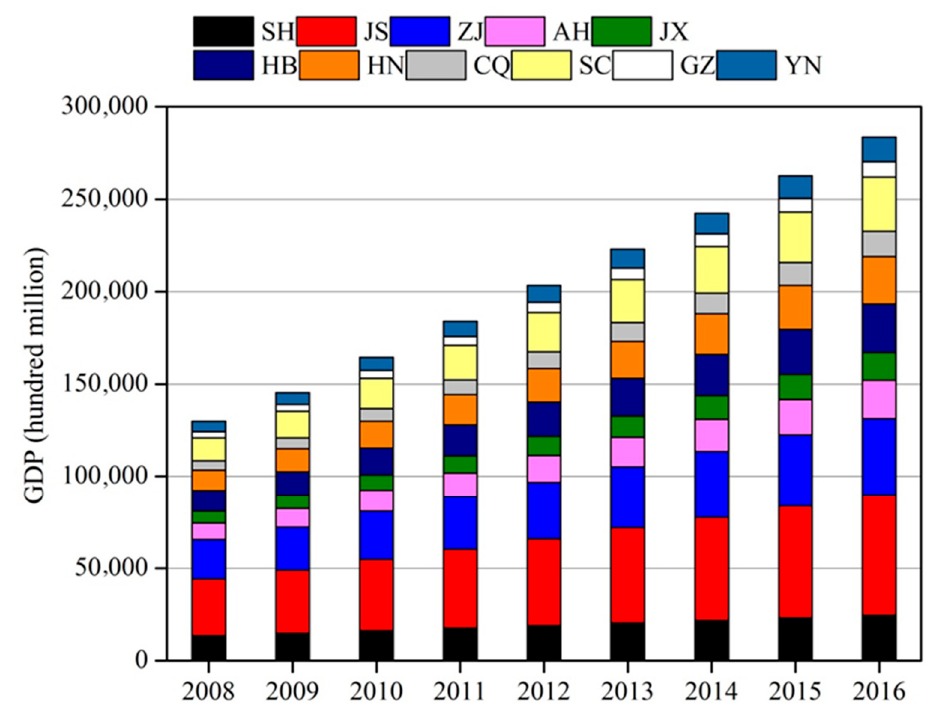
Figure 2. GDP in the YREZ during 2008–2016.